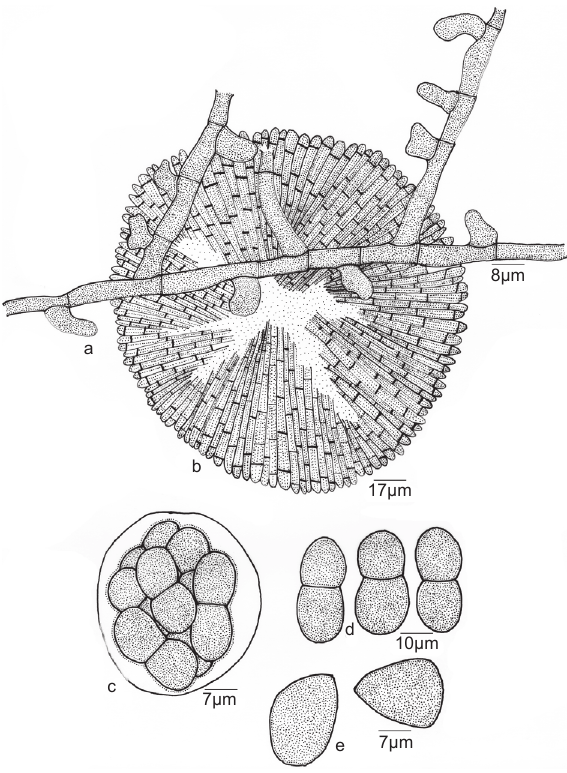
Figure 1. Asterina hugoniae sp. nov. a – Appressorium, b – Thyriothecium, c –